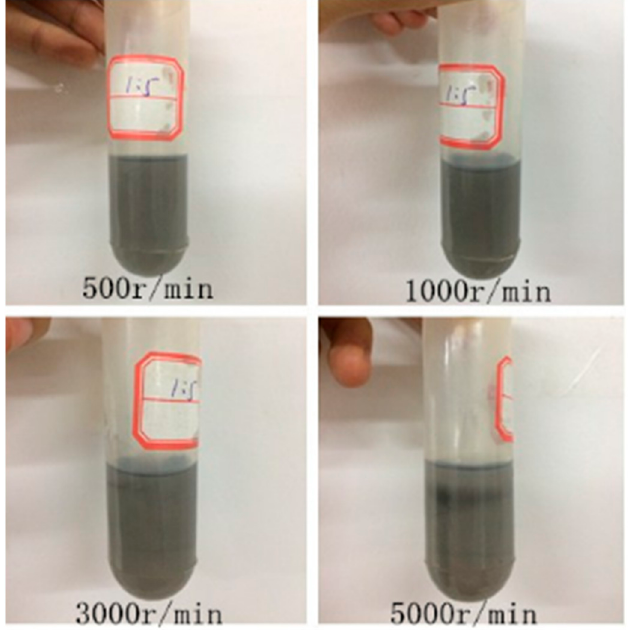
Figure 3. Separation images of graphene lubricant oil at different centrifugal speeds.